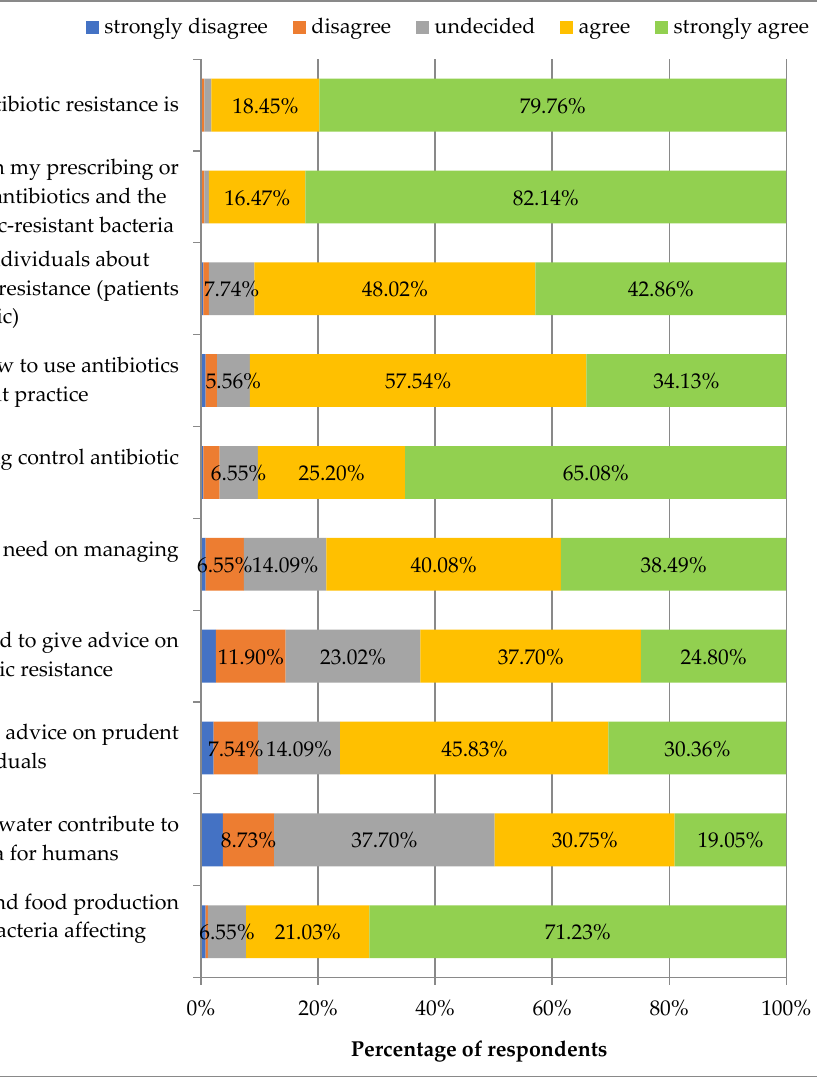
Figure 2. Do you agree or disagree with the following statements regarding antibiotic knowledge? Female respondents perceived their role in helping control ABR as key significantly more often than men (4.9 ± 0.4 vs. 4.6 ± 0.6), ( p = 0.010). Respondents working in clinical hospitals perceived their access to patient-targeted educational materials on prudent antibiotic use and ABR as less easy (3.5 ± 1.1) than those not working in clinics (3.9 ± 1.1), ( p = 0.027). The data on antibiotic subjective knowledge presented in Figure 2 did not correlate with: specialization status, type of specialization, or living in a large city ( p > 0.05) as well